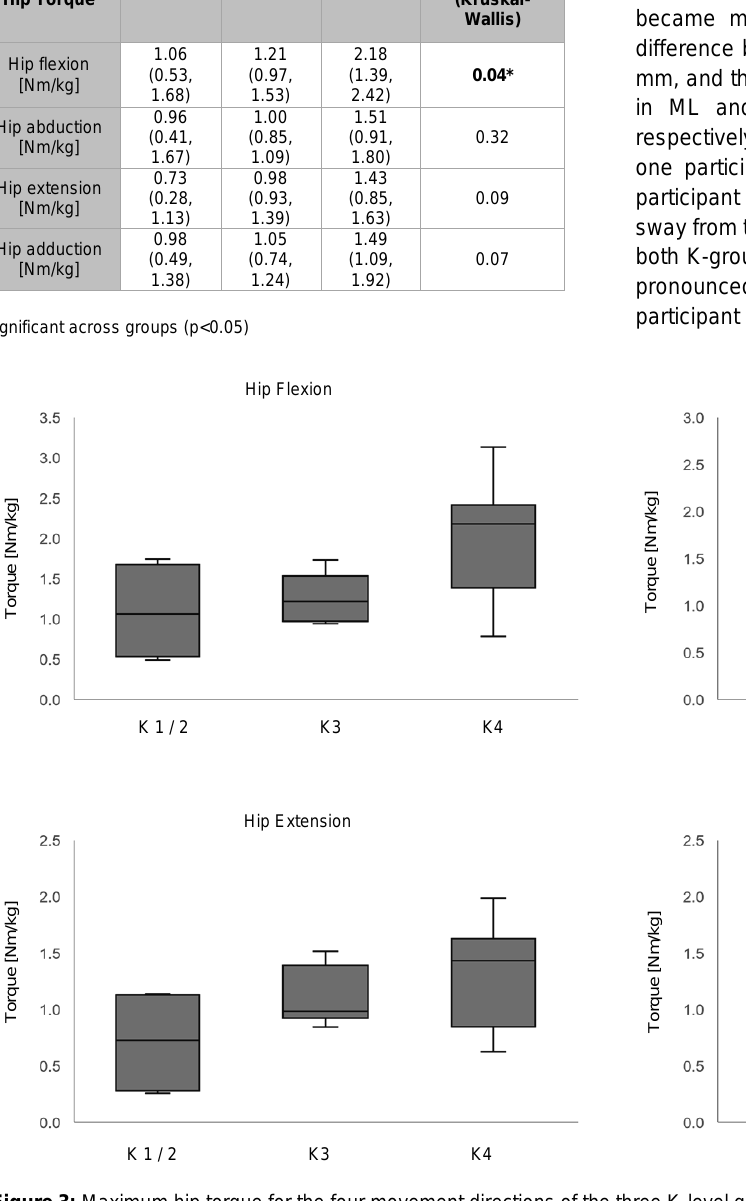
Figure 3: Maximum hip torque for the four movement directions of the three K-level